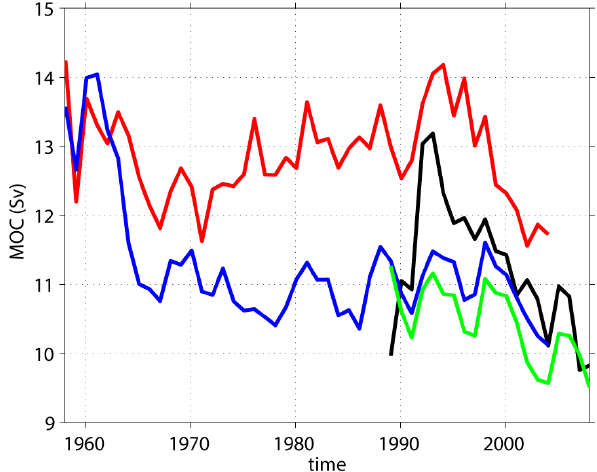
Figure 1. Time series of annual mean AMOC-Ek variability for the 4 model runs studied in this paper before they are linearly de- trended and deseasoned. ORCA025-G70 (red), ORCA1-R07 (blue), ORCA025-ERA (black), and ORCA1-ERA